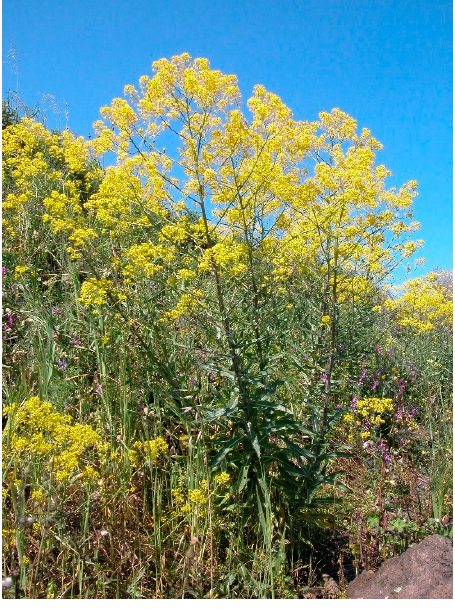
Figure 1. Isatis tinctoria L.